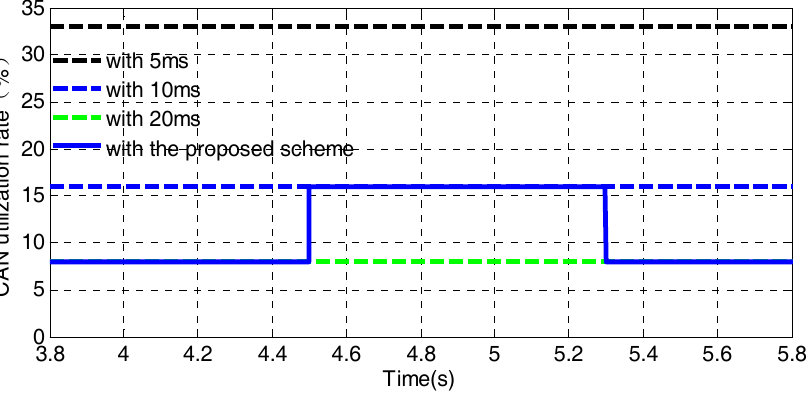
Figure 14. Network utilization rates of the loop in the HIL tests.